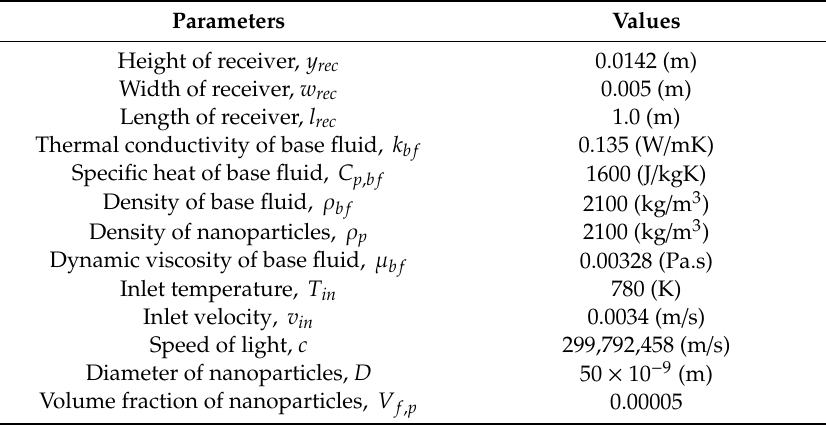
Table 1. Parameters used in the computational model.